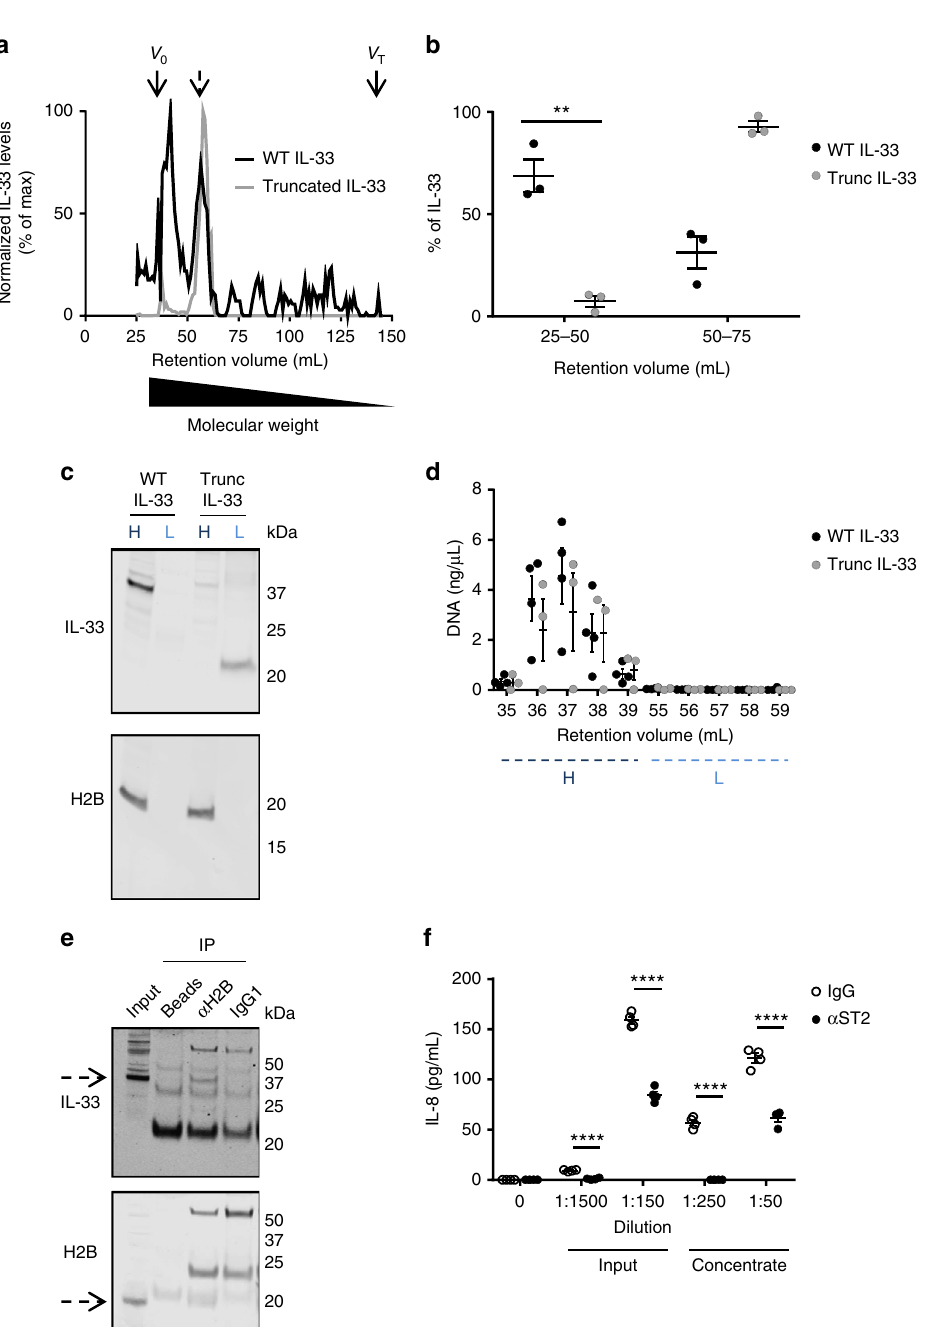
1:15000 1:150 1:250